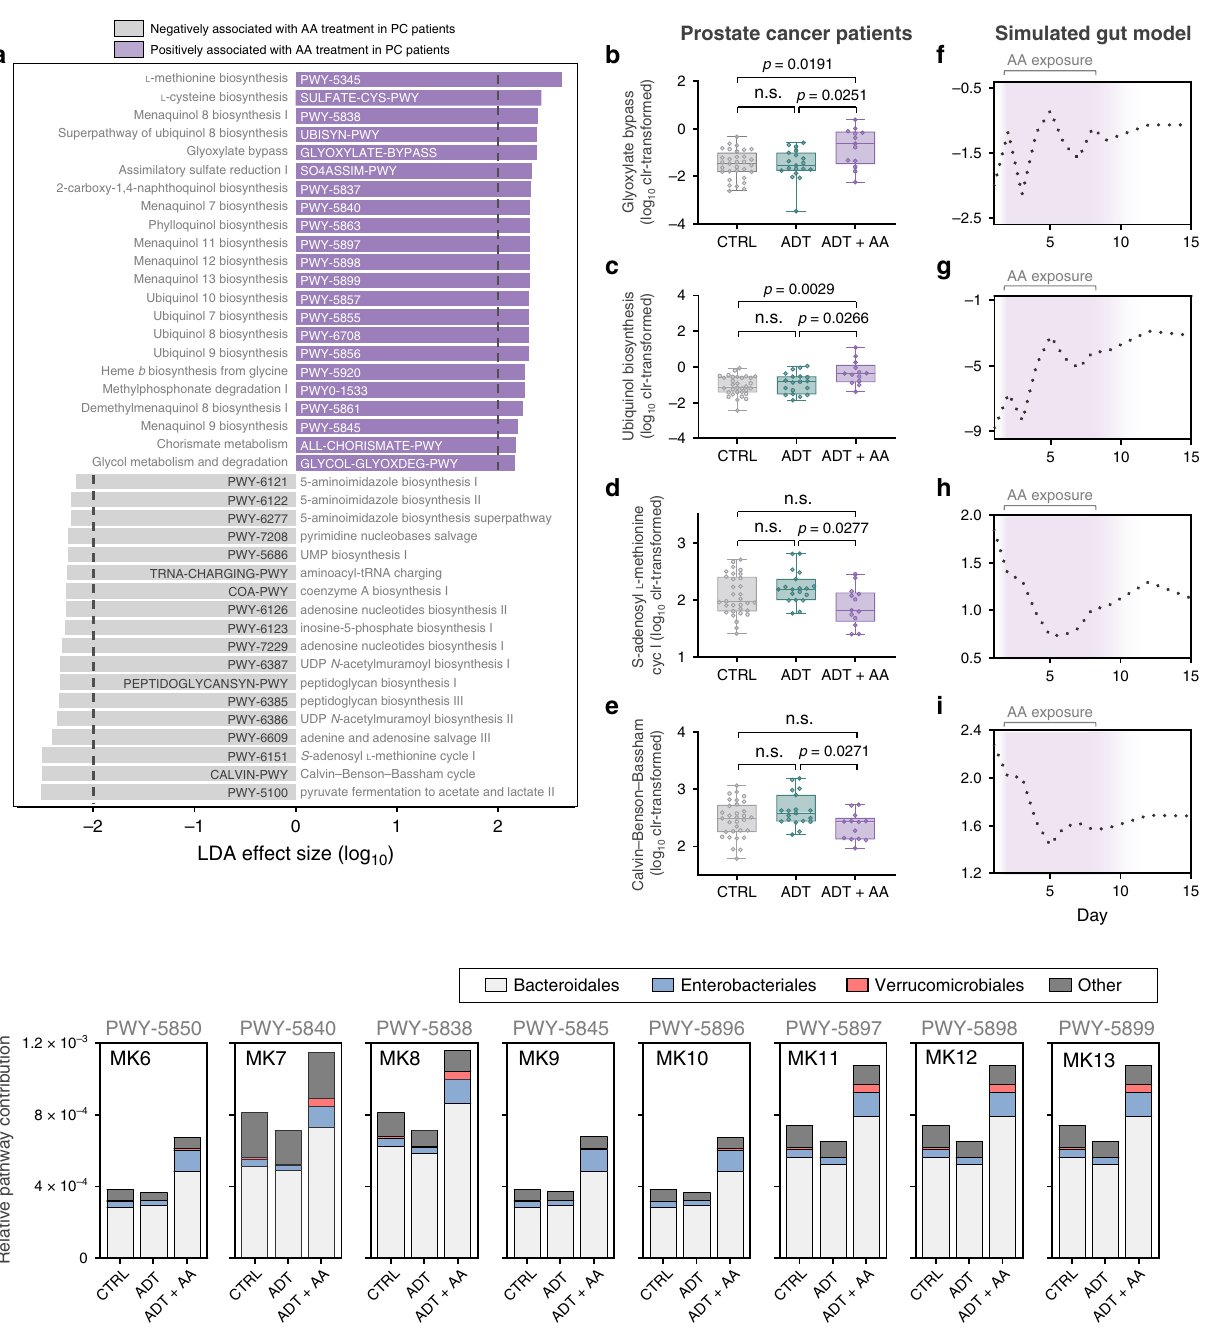
Fig. 4 Abiraterone acetate (AA) exerts a reproducible effect on the human gut microbiota in vivo and in vitro. a Differentially abundant pathways in patients receiving AA compared to those who were not. Multiclass analysis with the LEfSe algorithm was used to discriminate between AA effects overlapping systemic ADT exposure (LDA score >2 and p < 0.05 for all pathways shown). b – e Relative abundance of predicted pathways that were statistically increased in AA-treated patients. Data represent the median (line in box), IQR (box), and minimum/maximum (whiskers) of CTRL ( n = 33), ADT ( n = 21), and ADT + AA ( n = 14) patient samples. Statistics shown for Kruskal – Wallis tests with multiple comparisons corrected using